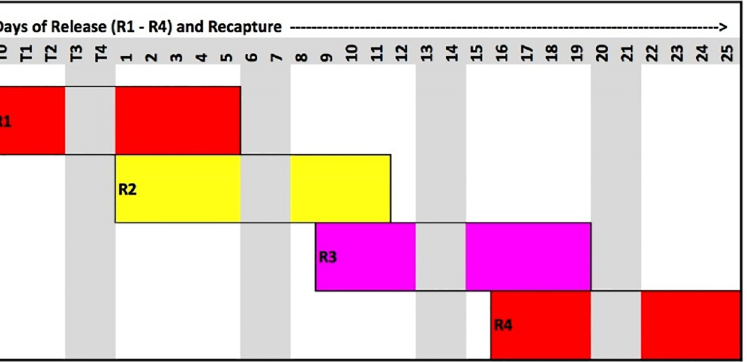
Fig 5. Release and recapture schedule of marked mosquitoes per day of release (R1–4) and recapture, Sı´tio Novo, Olinda, RMR, Brazil, July 22–August 21,